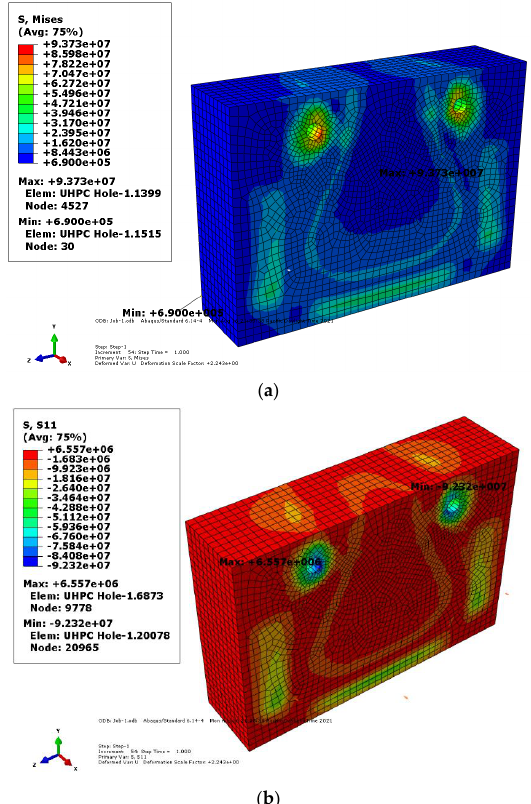
Figure 15. Stress of concrete in reaction (front) side for ( a ) von Mises stress and ( b ) stress on the x face in the x direction.